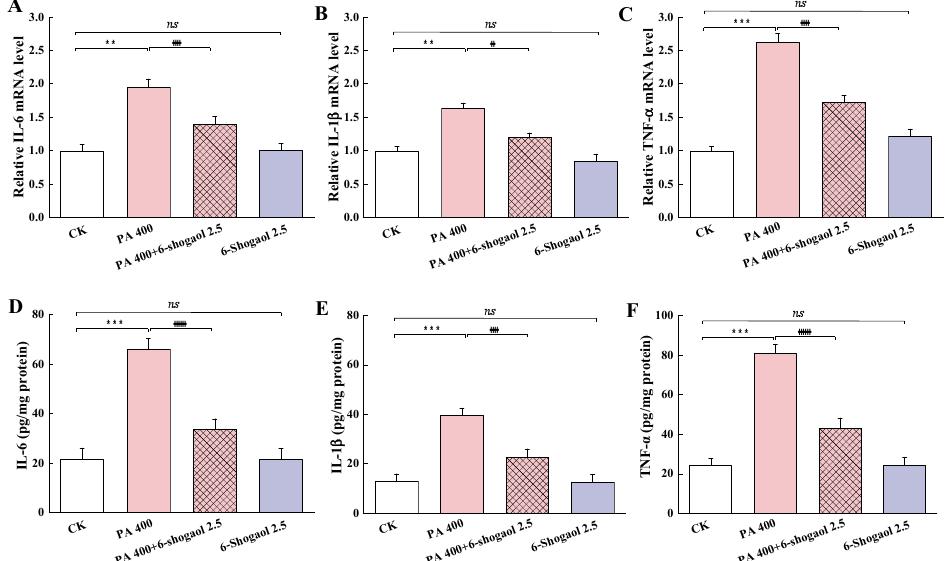
Figure 4. 6-Shogaol mitigated PA-induced production of pro-inflammatory cytokines in Caco-2 cells: ( A ) Interleukin-6 (IL-6) mRNA; ( B ) IL-1 β mRNA; ( C ) Tumor necrosis factor alpha (TNF- α ) mRNA; ( D ) IL-6 level; ( E ) IL-1 β level; ( F ) TNF- α level. Data are given as means ± standard deviations (n = 3). ** p < 0.01, *** p < 0.001 vs. the control; # p < 0.05, ## p < 0.01, ### p < 0.001 vs. the PA-treated group; ns indicates no significant difference between the 6-shogaol-treated group and the control at p < 0.05.